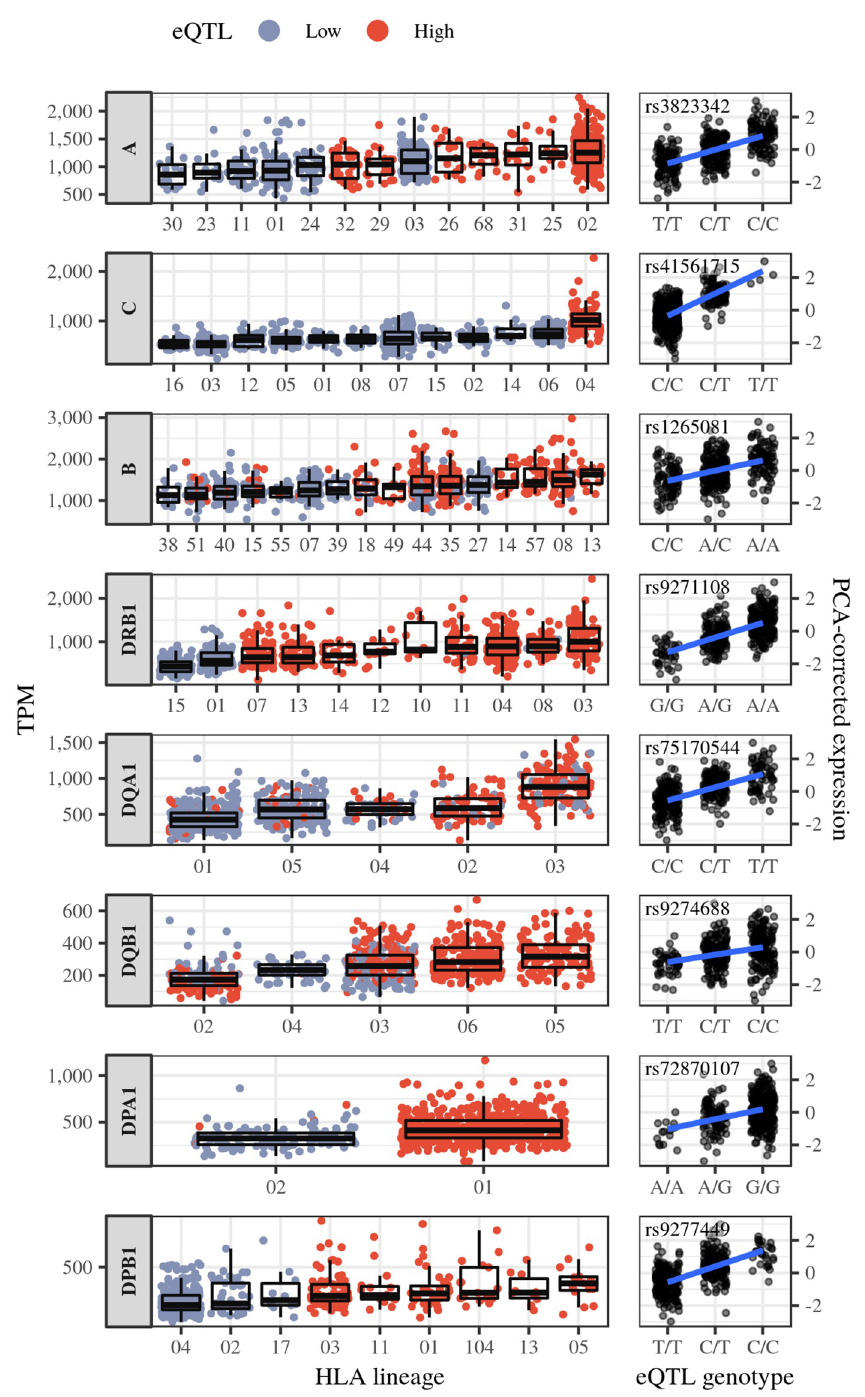
Fig 6. Expression levels for different HLA lineages and eQTL genotypes. For each locus panel we have: (left-hand side) expression estimates for each HLA allele in Transcripts per Million (TPM), and (right-hand side) gene-level estimates for each eQTL genotype in PCA-normalized estimates used for eQTL mapping. Allelic lineages with � 10 individuals are shown.